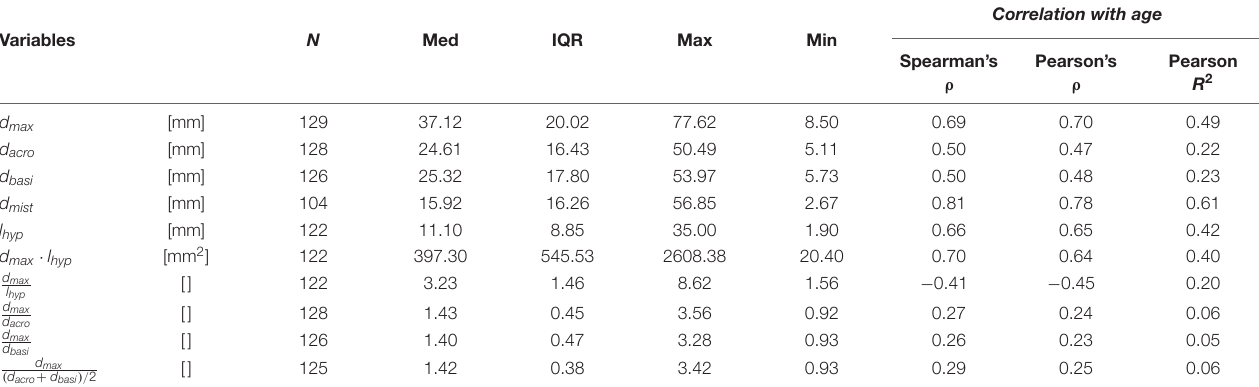
TABLE 1 | Dimensions of host branch hypertrophy and diameter of mistletoe